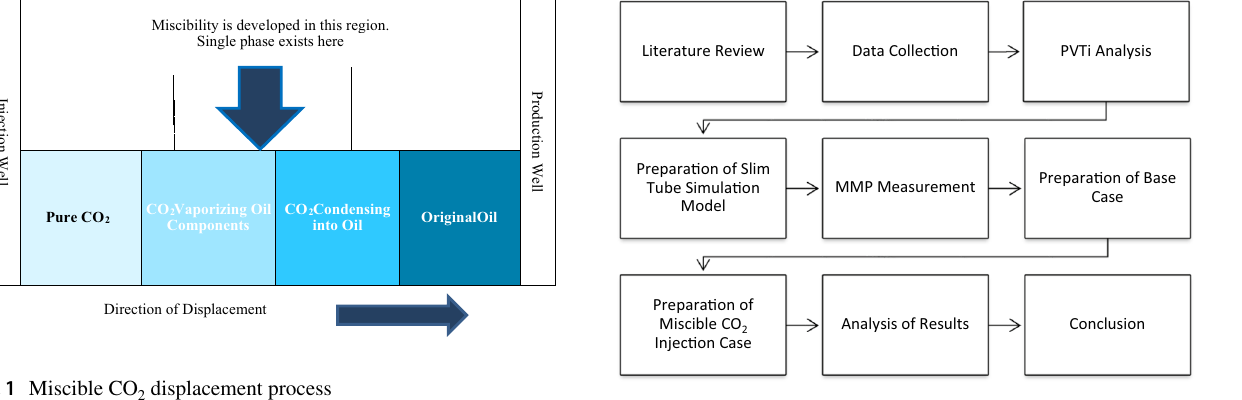
Fig. 2 Research methodology layout used in this